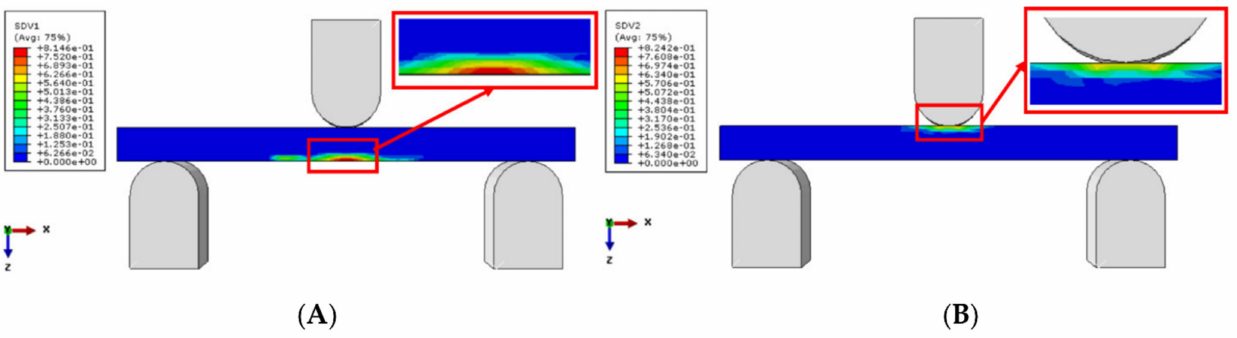
Figure 13. Distribution of the damage variable fields. ( A ) Tension damage and ( B ) compression